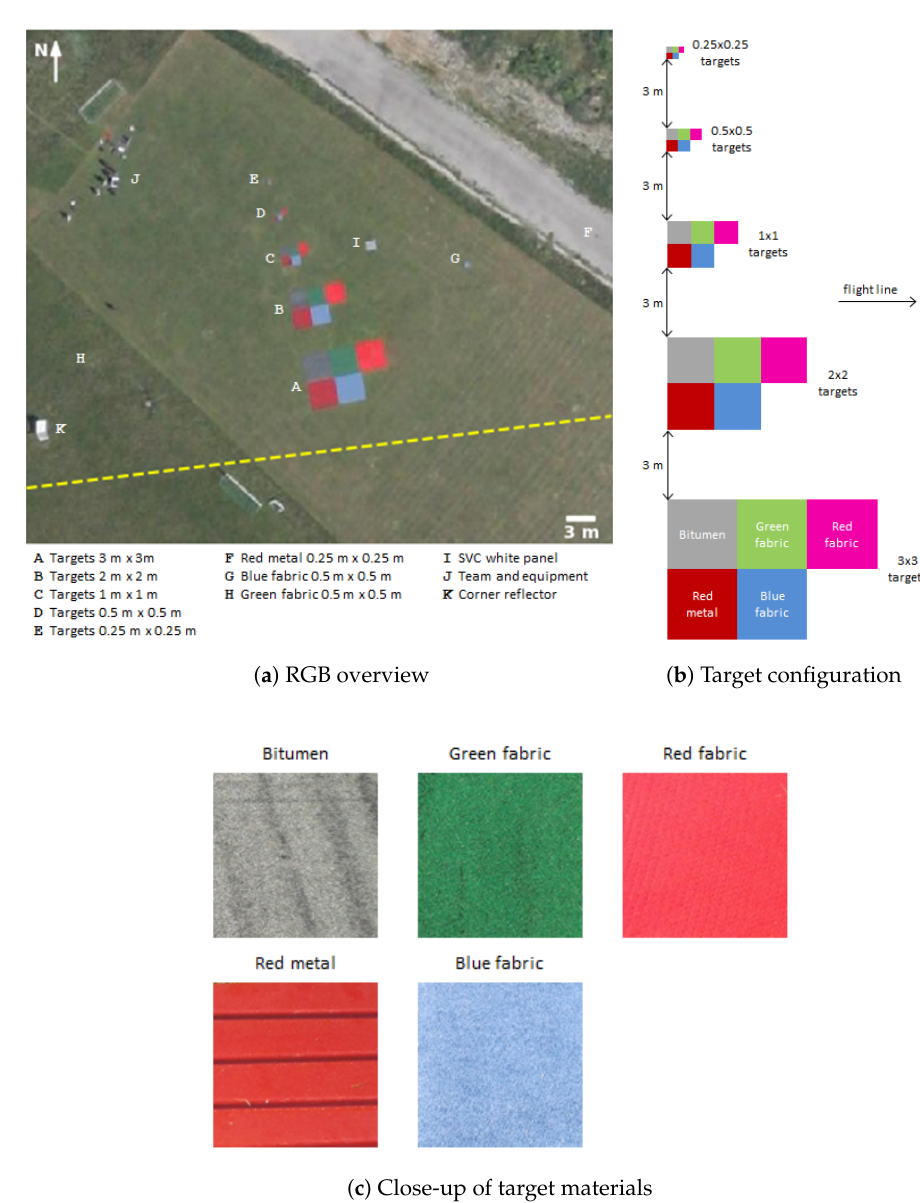
Figure 1. DLR HySU benchmark targets. Panel ( a ) shows an RGB overview of the football field with the targets as imaged by the 3K camera. The ground track of the aircraft is shown by the dashed yellow line. The schematic configuration of the different targets is illustrated in ( b ) and a close-up of the target materials with the same spatial arrangement is shown in the bottom panel ( c